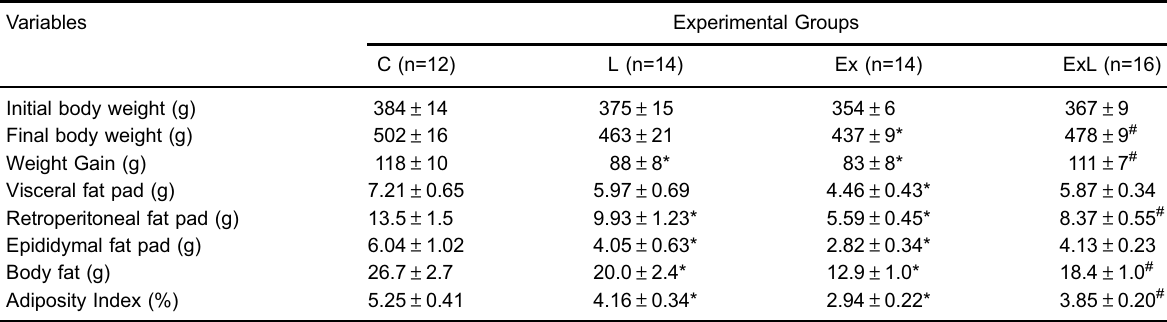
Table 1. General